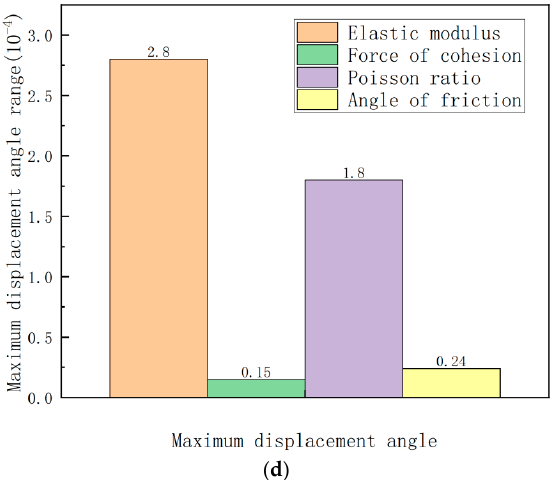
Figure 8. Range of the structural dynamic response index corresponding to the variation in soil parameters. ( a ) Maximum axial force range of the feature points. ( b ) Maximum shear range of the feature points. ( c ) Maximum bending moment range of the feature points. ( d ) Maximum displacement angle range of the feature points on roof and floor. Table 5. Dynamic response values under horizontal and vertical earthquakes.